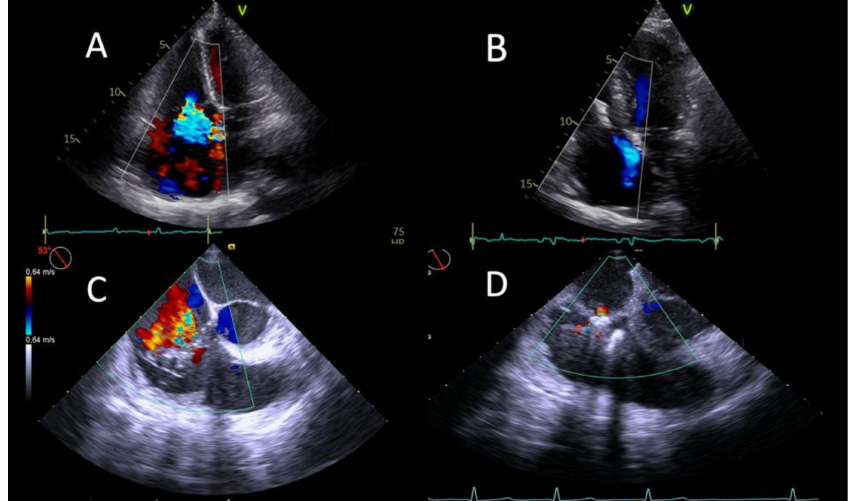
Figure 1. Echocardiographic pictures of successful TR reduction after TEER. Transthoracic echocar- diographic four-chamber view at baseline ( A ) and at discharge ( B ) after implantation of one TriClip XT. Transoesophageal echocardiographic right ventricle inflow/outflow view showing severe tri- cuspid regurgitation mainly originating from septal and anterior leaflet at baseline ( C ) and traces of regurgitation after implantation of one device ( D